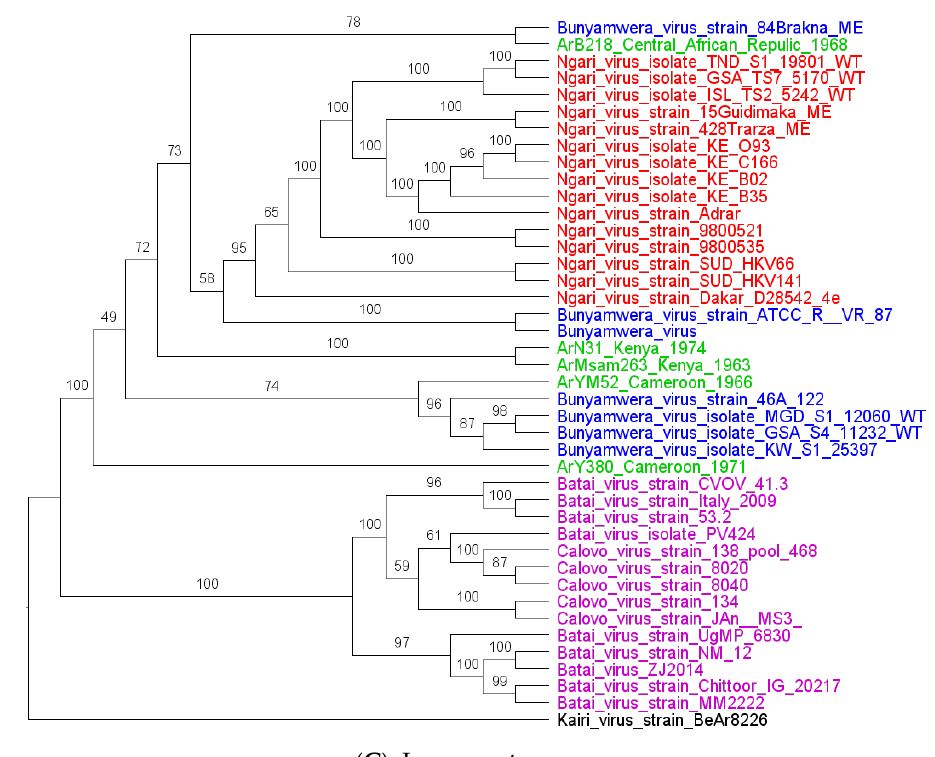
Figure 2. Maximum likelihood trees were obtained from the S ( A ), M ( B ), and L ( C ) segments analysis. Legends: study strain (green), Batai virus (pink), Bunyamwera (red), and Ngari (blue). The strain characterized in this study is colored purple.